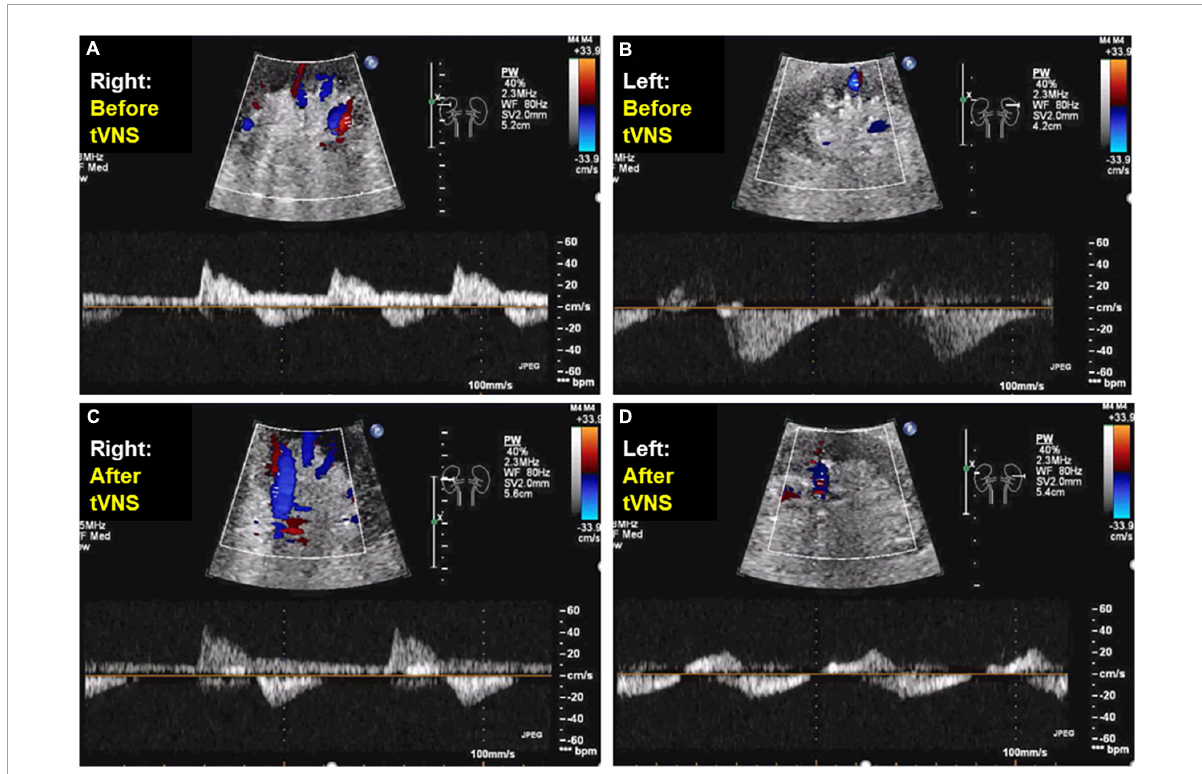
FIGURE5 Doppler-derived intrarenal venous flows before and after transcutaneous electrical vagus nerve stimulation. After transcutaneous electrical vagus nerve stimulation during 1 h, while the right intrarenal venous flow was not changed as a monophasic pattern (A,C) , the left intrarenal venous flow was changed from a discontinuous biphasic pattern as one fusion wave of two waves (B) to a discontinuous pattern with a systolic interruption (D) .